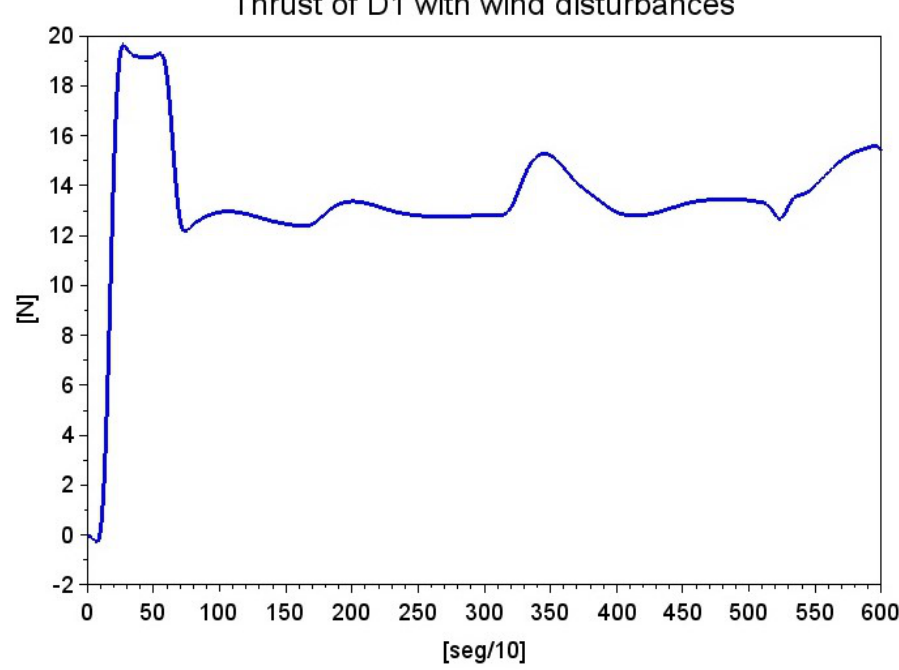
Figure 11. Plot of the instantaneous thrust of leader drone ( D 1 ) during the simulation under wind disturbances.